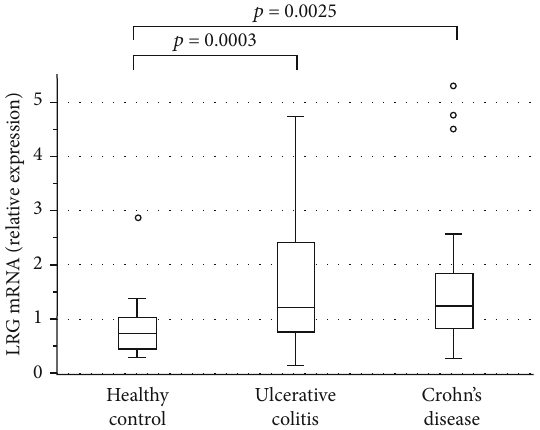
Figure 5: Leucine-rich alpha-2 glycoprotein (LRG) mRNA levels in peripheral blood mononuclear cells obtained from patients with ulcerative colitis, patients with Crohn ’ s disease, and healthy control participants. The bars indicate the median ± 25 th percentile. The lower bar indicates the 10 th percentile, and the upper bar indicates the 90 th